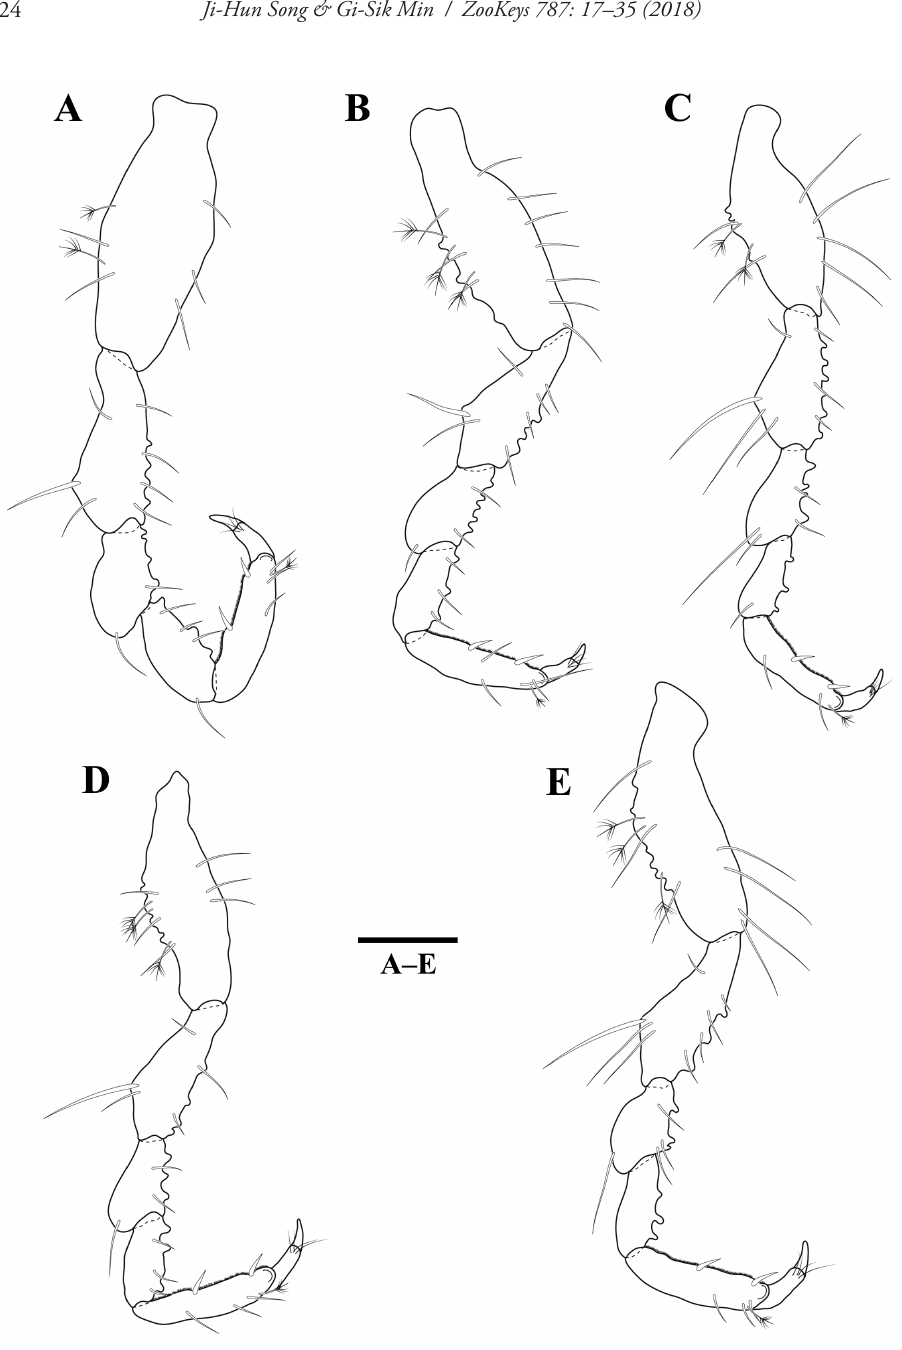
Figure 3. Gnathia koreana sp. n., male holotype. A pereopod 2 B pereopod 3 C pereopod 4 D pereo- pod 5 E pereopod 6. Scale bars: 0.2 mm ( A–E